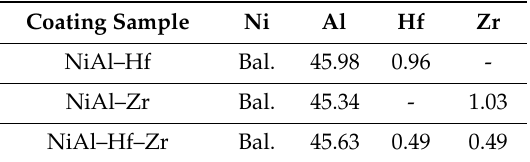
Table 2. Chemical composition of the as-deposited coatings determined by X-ray fluorescence spectrometry (XRF, in